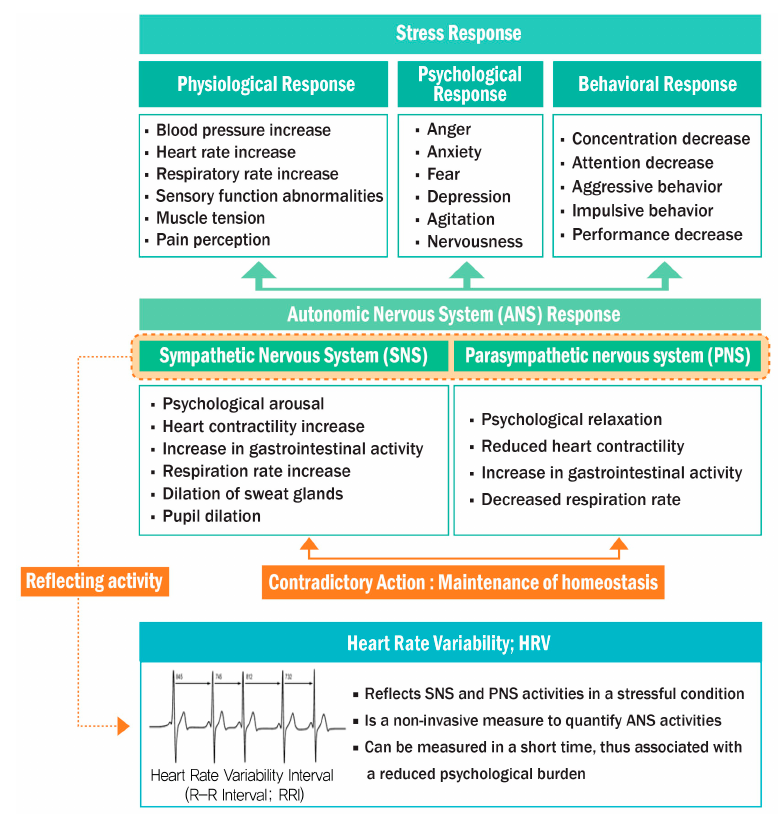
Figure 1. Relationships between stress, ANS, and HRV. Analytical methods of HRV vary, and the most common methods are time-domain analysis and frequency-domain analysis. The time-domain analysis computes the time intervals between two adjacent heartbeats within normal limits. It is advantageous for long-term monitoring but limited because it does not quantify ANS balance and